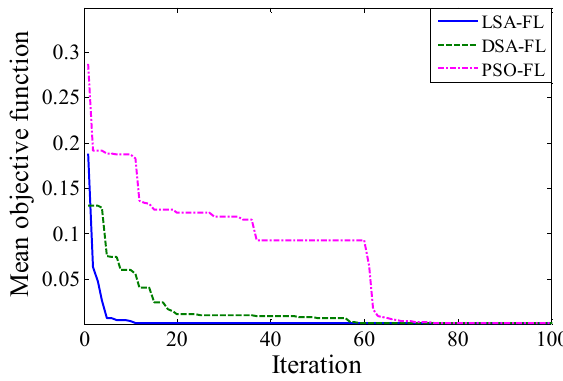
Figure 11. Performance comparisons based on LSA ‐ FL, DSA ‐ FL, and PSO ‐ FL.